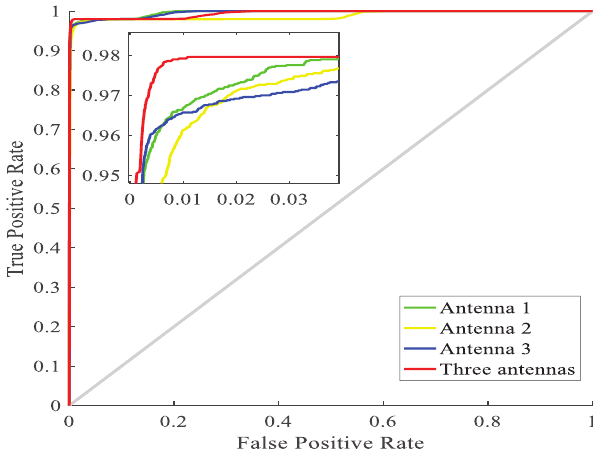
Figure 10. ROC curves under different